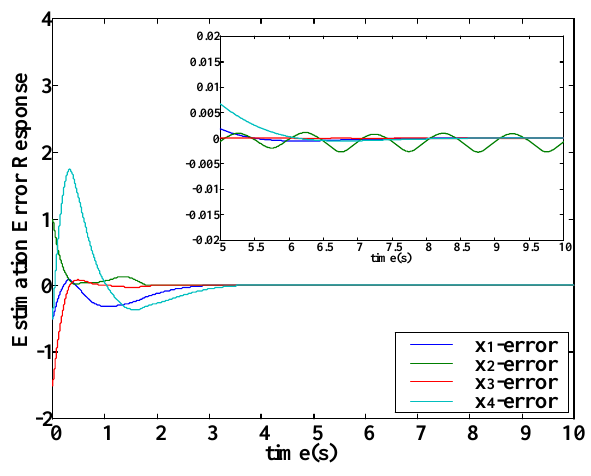
Figure 1. State observation by sliding mode observer (SMO).